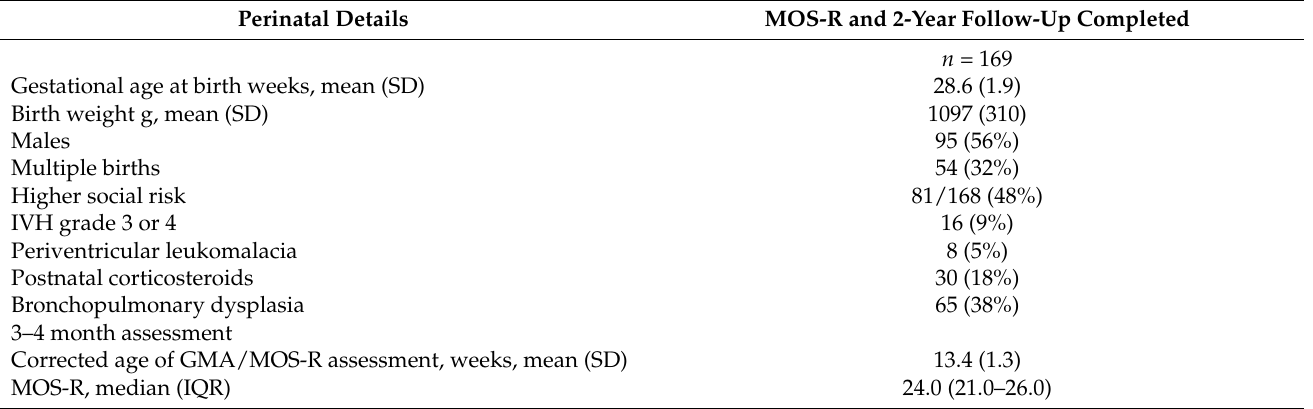
Table 1. Perinatal characteristics of infants assessed at 3–4 months and 2